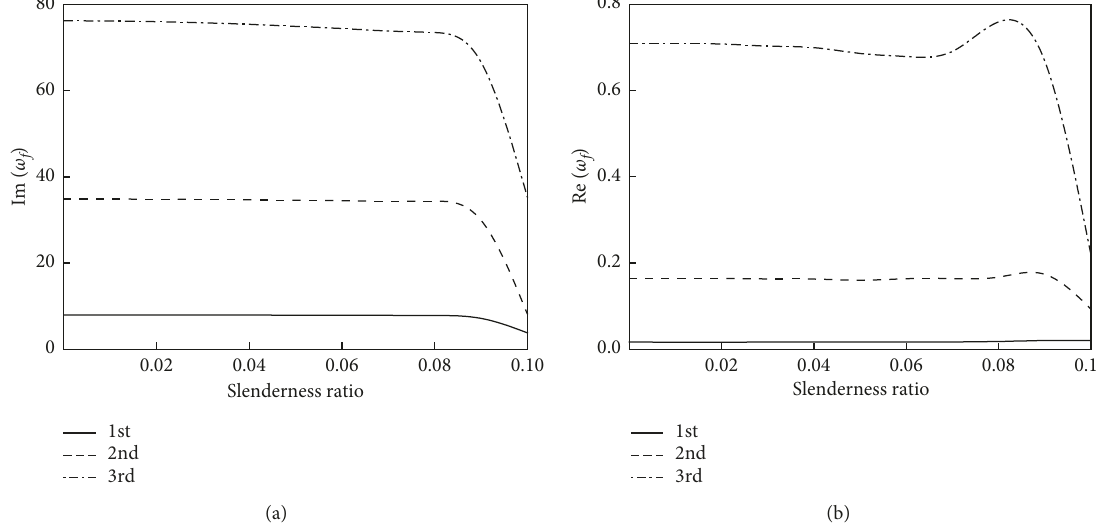
� 0 . 25, g � 0 . 025, ω � 10, and α � 0 1